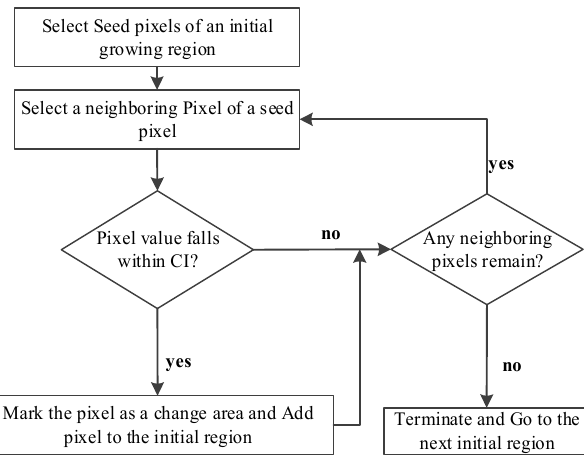
Figure 6. Proposed modified region growing algorithm (RGA).